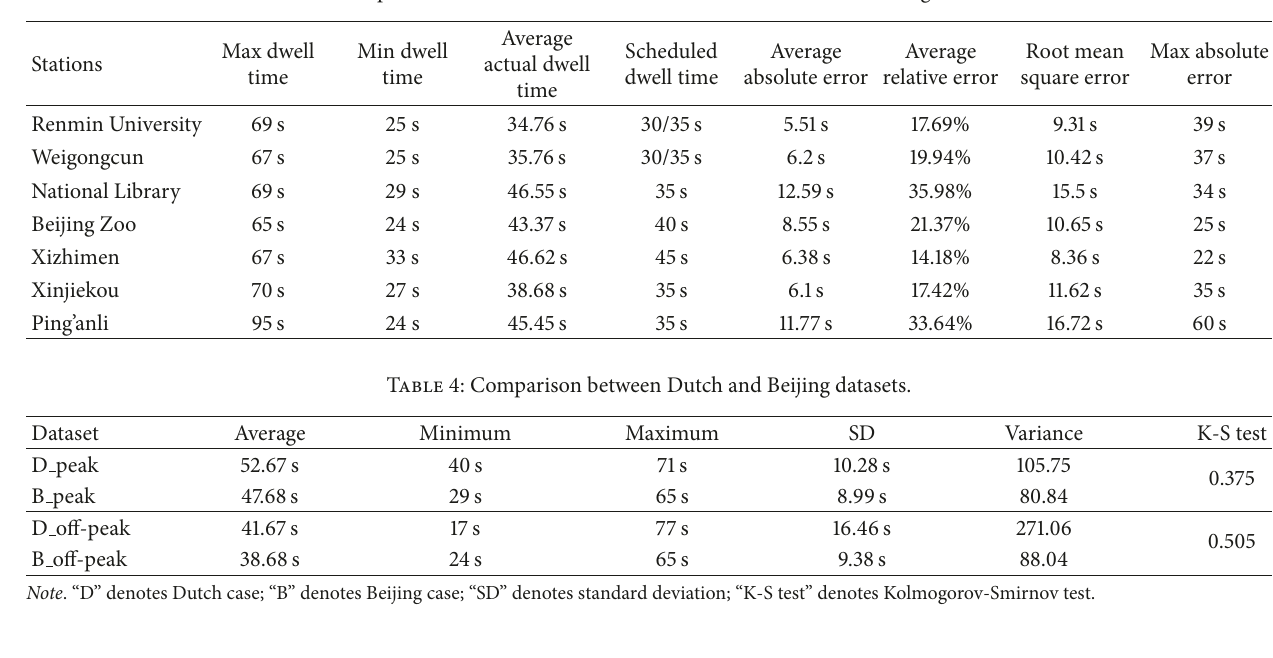
Table 3: Comparison of the actual and scheduled dwell times of the investigated stations.